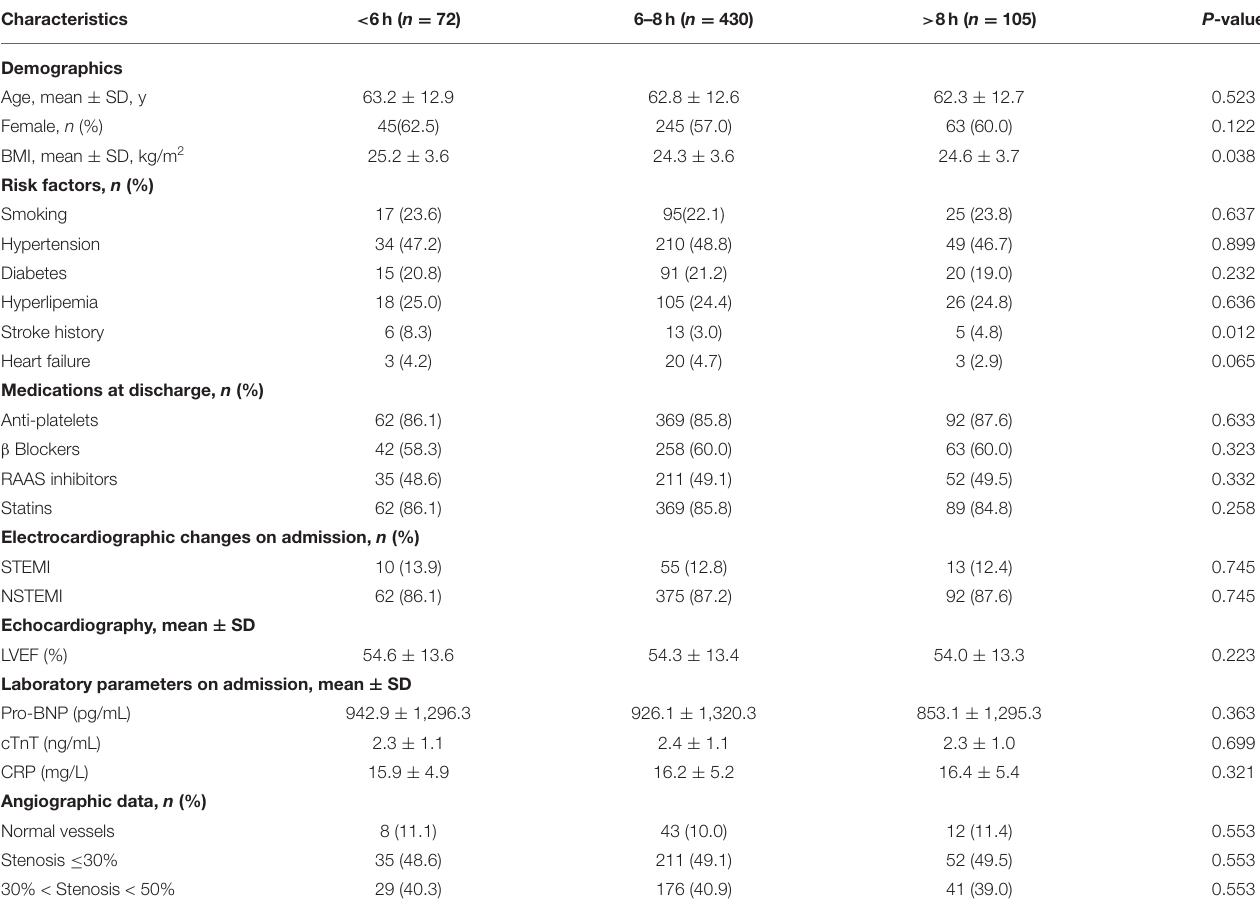
TABLE 2 | Demographic and clinical characteristics of the patients classified by level of sleep duration. Characteristics